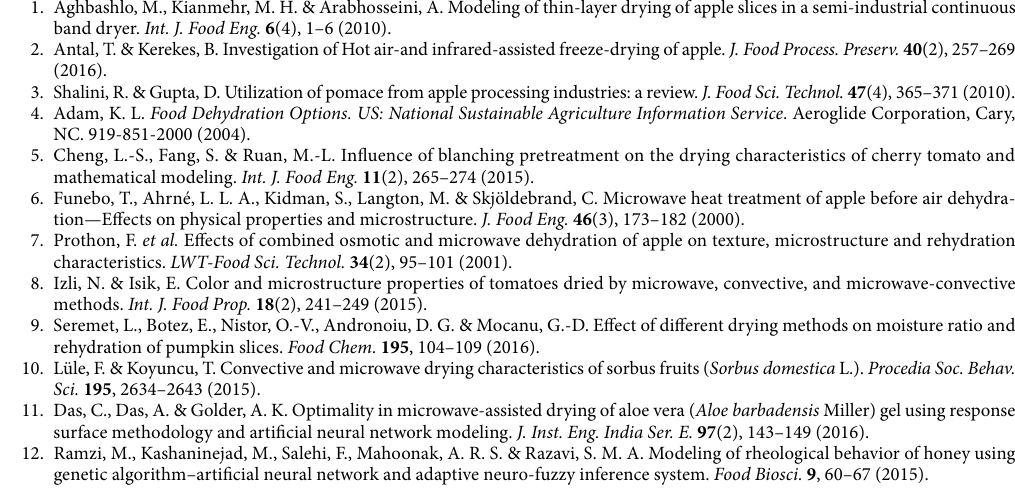
Table 6. The best values of evaluation criteria for FFBF and CFBF networks in different conditions of the number of layers and threshold functions for MR in MD dryer. The best values of the evaluation criteria are shown in bold